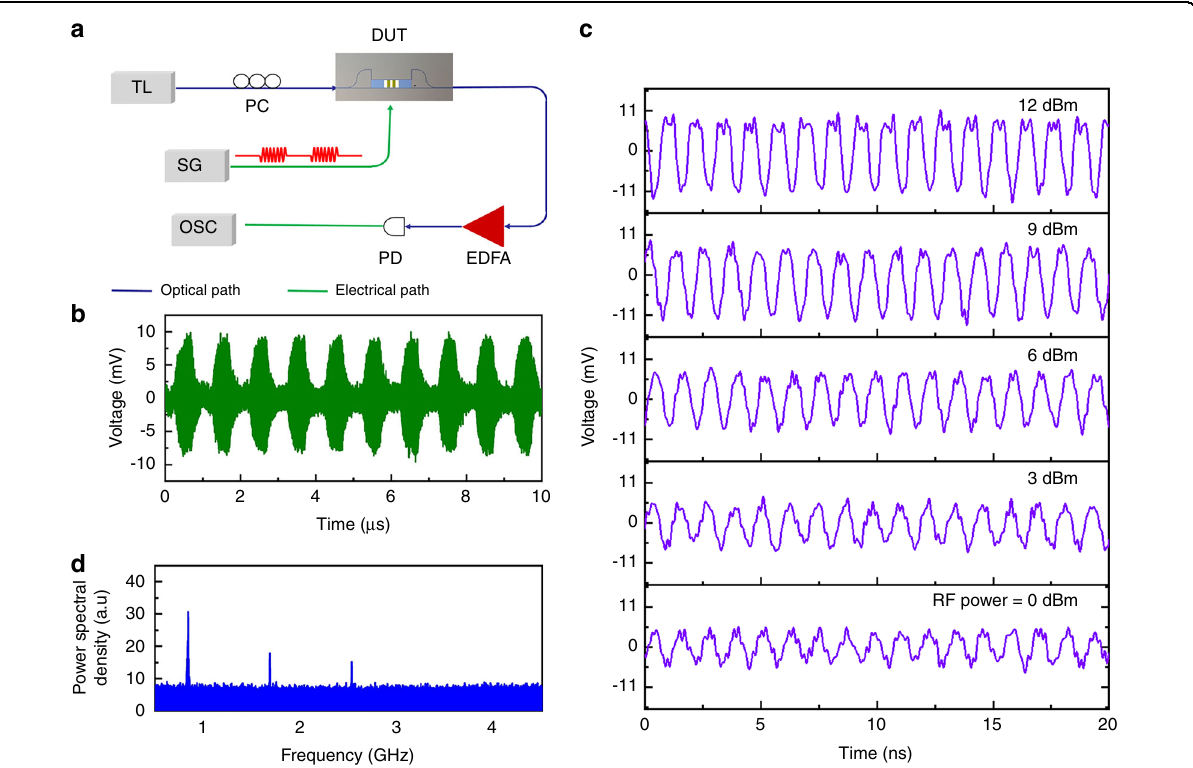
Fig. 5 Experimental demonstration of an on-off modulation link using our built-in push-pull AO modulator. a Schematic diagram of an on- off modulation link. The 1 MHz on-off modulated RF signal at 0.84 GHz is delivered from a signal generator to the device under testing via a microwave probe. b Time-domain oscillogram of the amplitude-modulated optical wave sampled within 10 μ s under 6 dBm RF power. c Measured time-resolved oscillograms recorded for different RF powers applied in our AO modulator. d Fourier transformation of the time-domain oscillogram corresponding to the input of 6 dBm RF power. SG: signal generator, EDAF: erbium-doped fi ber ampli fi er, OSC: